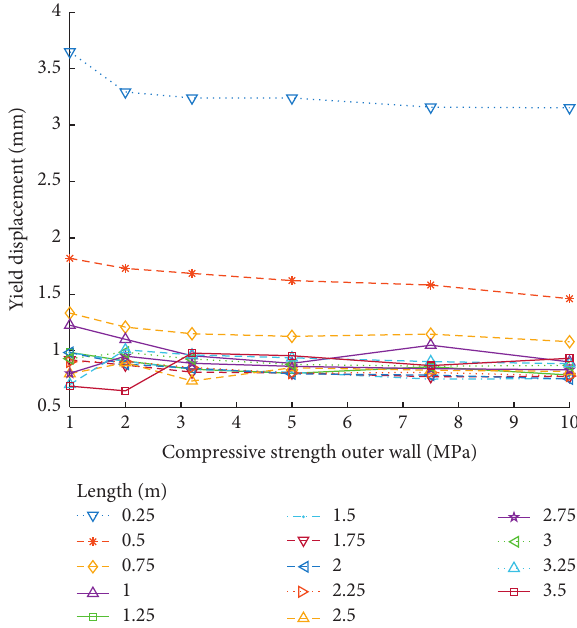
Figure 16: Yield displacement vs compressive strength of outer wall for different